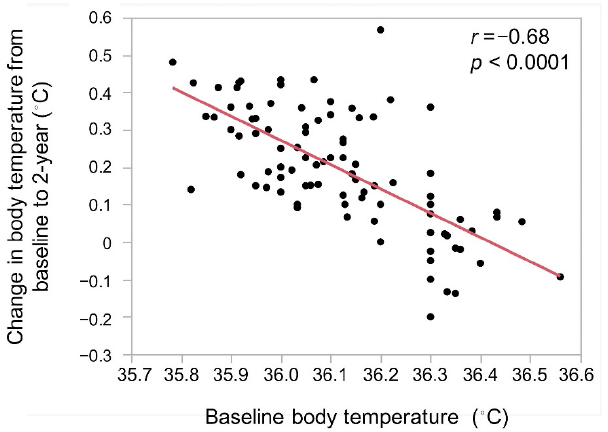
Figure 4. Correlation between change in body temperature after exercise training and baseline body temperature.